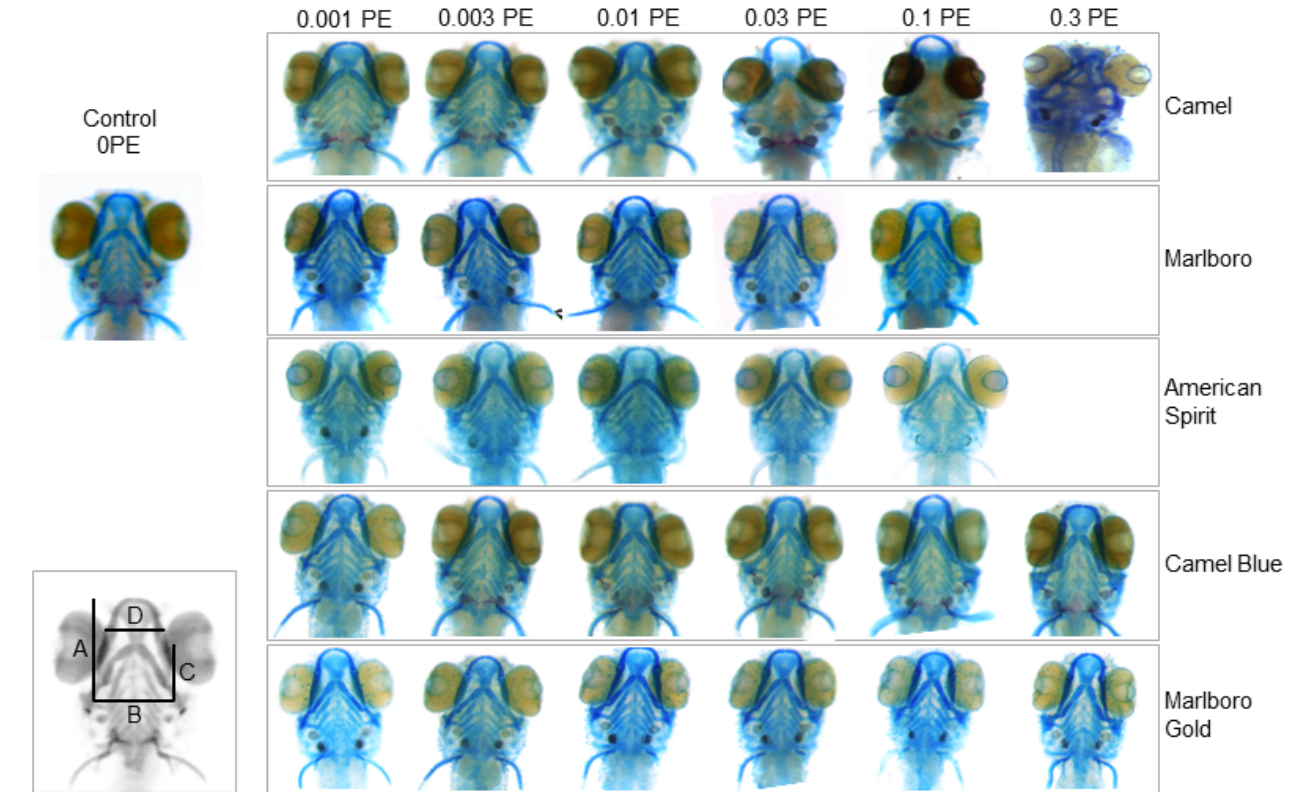
Figure 3. Effect of tobacco products on craniofacial cartilage development in exposed embryos. Embryos were placed in a tobacco smoke solution (in E3 embryo media) at 5 hpf and collected, fixed, and stained with Alcian Blue at 6 dpf. Representative images of the surviving larvae heads, n = 24. (Inset) Schematic of the parameters measured to quantitatively assess cartilage defects. Distance A: from the left hyosymplectic to the top of anterior limit. Distance B: from the left hyosymplectic to the right hyosymplectic. Distance C: from the right hyosymplectic to the top of ceratohyal. Distance D: from the right articulation to the left articulation (compare Figure